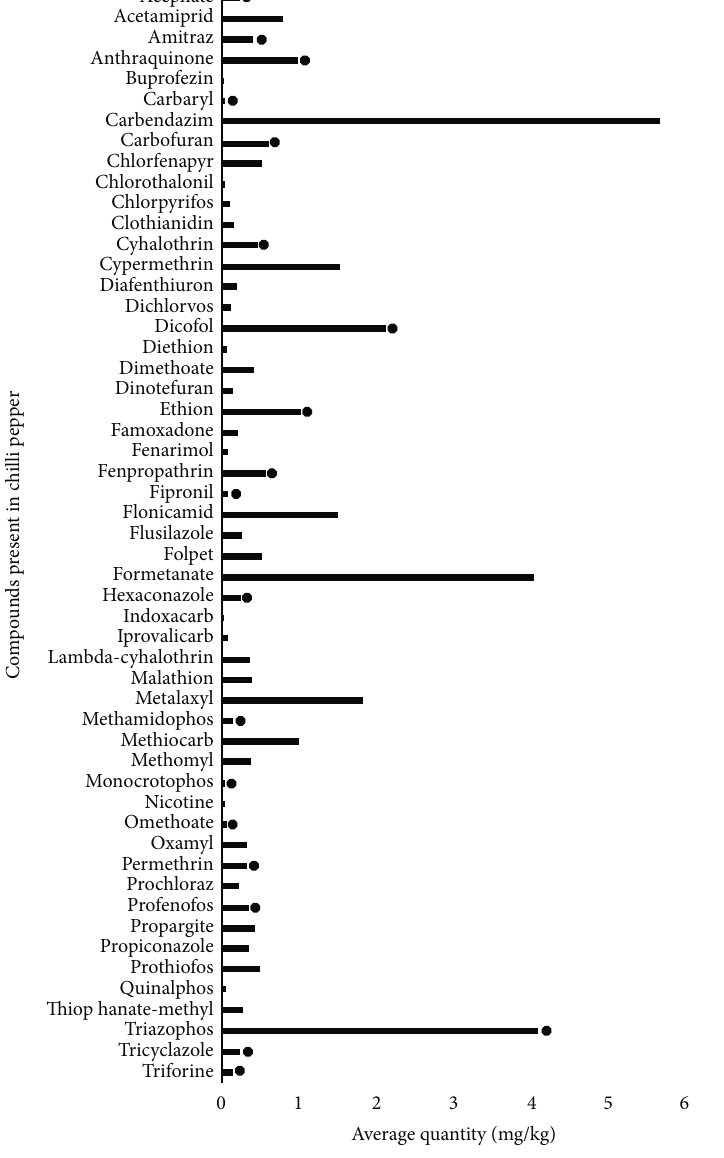
Figure 6: Pesticide residue levels reported by RASFF of the European Union in chilli